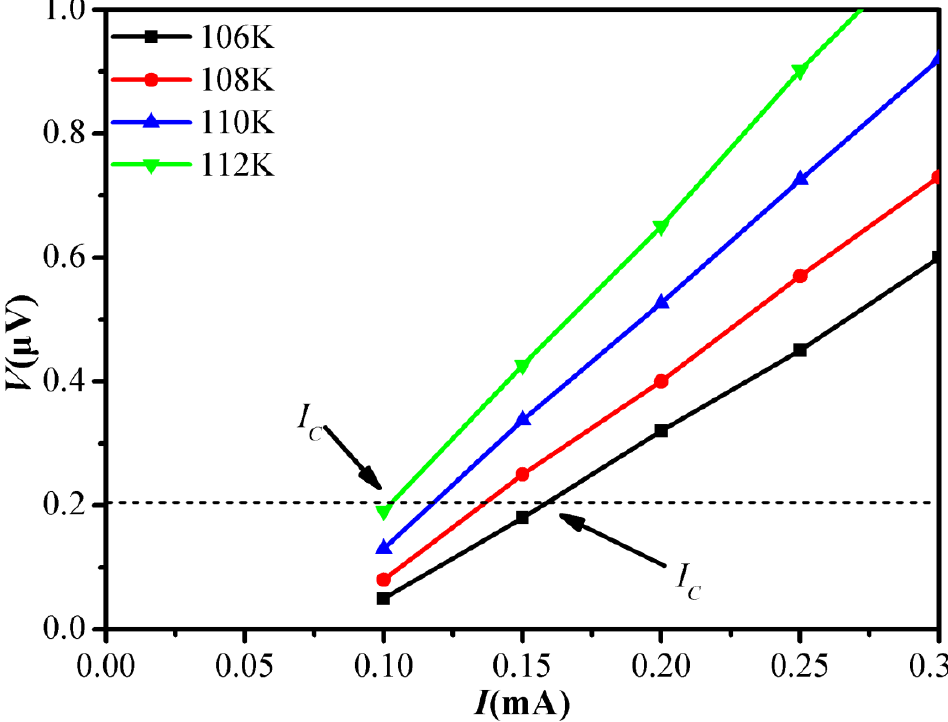
Figure 1. I – V curves of pure B(P)SCCO (A1) at 106, 108, 110, and 112 K. Figure 2a,b show the relationship between J C and the temperature of pure a MgB 2 and a MgB 2 doped with 0.5 wt% Y 2 O 3 :Sm 3+ , Y 2 O 3 , Y 2 O 3 :Eu 3+ , and Y 2 O 3 :Eu 3+ +Ag. Figure 2c,d depict the relationship between J C and the temperature of pure b MgB 2 and b MgB 2 doped with 0.8 wt% Y 2 O 3 :Sm 3+ , Y 2 O 3 , Y 2 O 3 :Eu 3+ , and Y 2 O 3 :Eu 3+ +Ag. Figure 2e,f demonstrate the relationship between J C and the temperature of pure c MgB 2 and c MgB 2 doped with 1.2 wt% Y 2 O 3 :Sm 3+ , Y 2 O 3 , Y 2 O 3 :Eu 3+ , and Y 2 O 3 :Eu 3+ +Ag. The J C of a MgB 2 , b MgB 2 , and c MgB 2 are 8.9 × 10 4 , 7.8 × 10 4 , and 7.2 × 10 4 A/cm 2 at 20 K. As observed, the J C of pure MgB 2 and doped samples decreases with the increase in temperature, which is consistent with the results of [28,47,48]. The J C of pure MgB 2 is comparable to references [49,50]. The J C decreases slowly when the temperature is lower, and the decreasing rate increases with the rise in temperature. The doping of Y 2 O 3 :Eu 3+ and Y 2 O 3 :Eu 3+ +Ag luminescent inhomogeneous phases increases the J C . The c MgB 2 series samples with the smallest particle size have a higher dopant content, and the most increases in J C . At T = 34 K, the J C of Y 2 O 3 :Eu 3+ and Y 2 O 3 :Eu 3+ +Ag doped samples increases by 32% and 38% compared with purely that of c MgB 2 , respectively. The J C of non-luminescent dopant-doped MgB 2 samples first reduces to a minimum value, while the luminescent inhomogeneous phase-doped samples can have the J C at a higher temperature. For example, the J C of pure c MgB 2 reduces to a minimum value at 36.8 K, and the J C of 1.2 wt% Y 2 O 3 :Sm 3+ and Y 2 O 3 doped samples reduces to a minimum value at 35.8 and 35.6 K, while the J C of 1.2 wt% Y 2 O 3 :Eu 3+ and Y 2 O 3 :Eu 3+ +Ag doped samples decreases to a minimum value at 37.8 and 38 K, respec- tively.